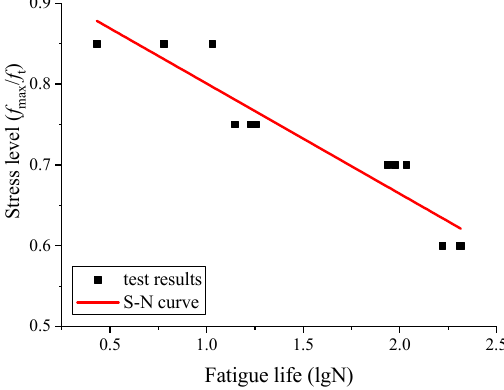
Figure 14. Least-square fitting of S-N curve fitting.